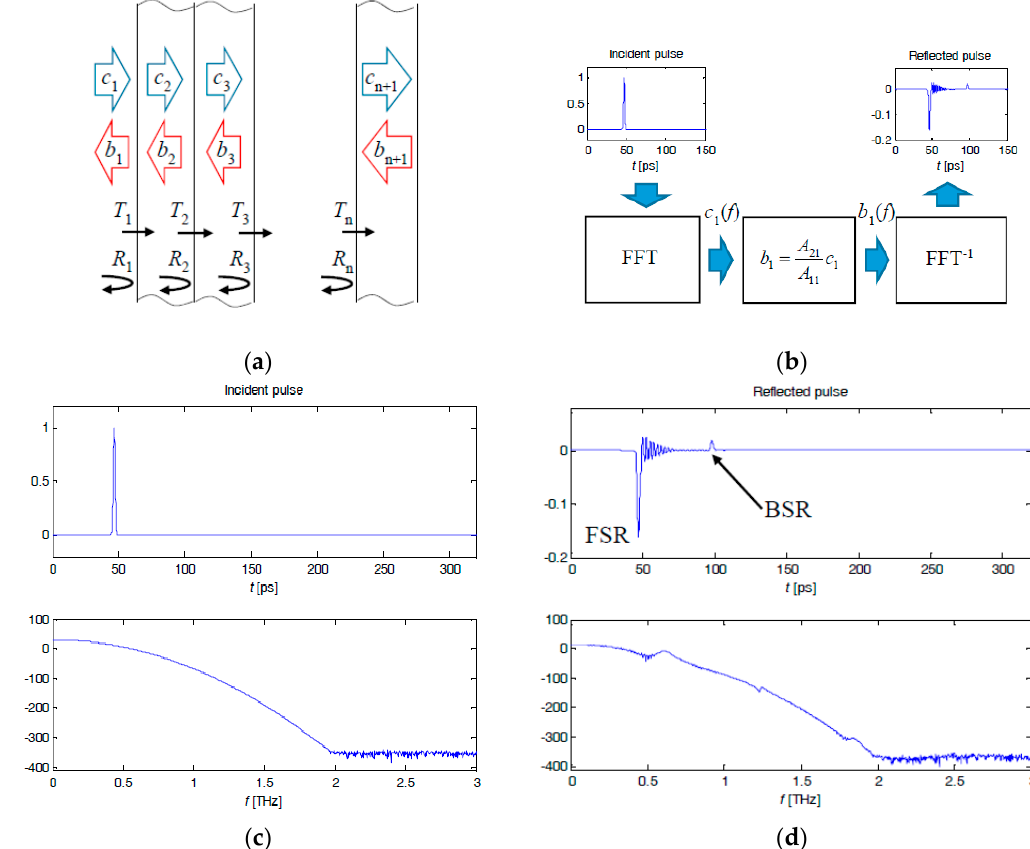
Figure 8. Analytical model: ( a ) cascade connection of multiple layers; ( b ) block scheme of reflected signal calculation; ( c ) time domain excitation signal (and its spectrum) in the form of a wideband Gaussian pulse; and ( d ) the signal obtained using the analytical model for reflection arrangement (and its spectrum).